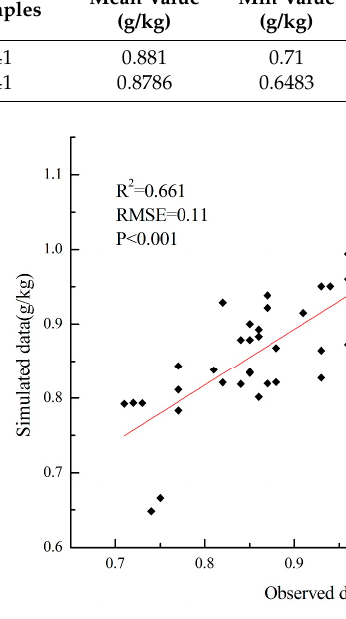
Figure 5. Observed and simulated results for the random sample points.